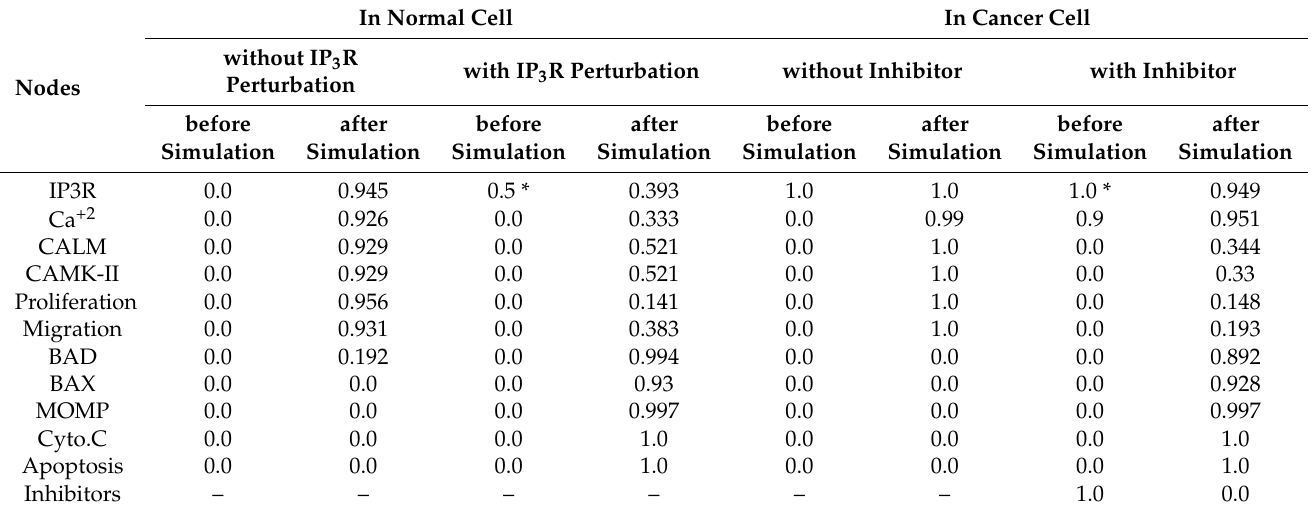
Table 1. Parameter values of onco- & proto-oncogenes interacting with IP 3 R before and after simulations generated in Jimena. In Normal Cell In Cancer Nodes